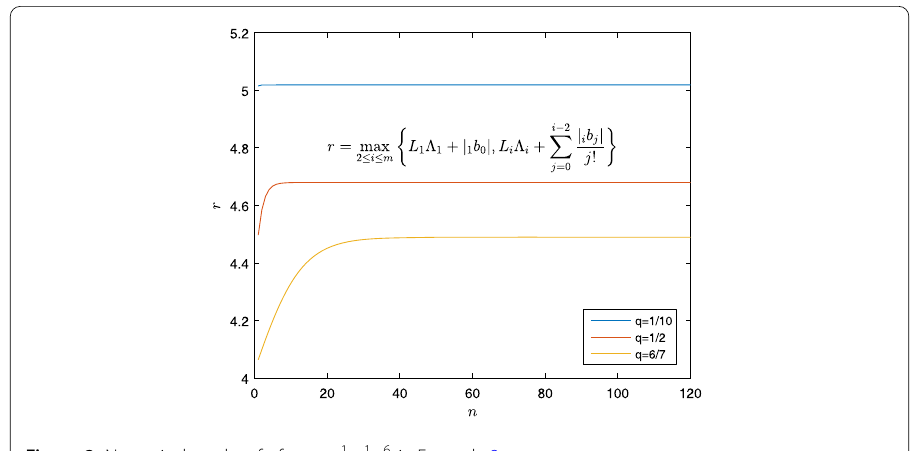
Figure 2 Numerical results of r for q = 1